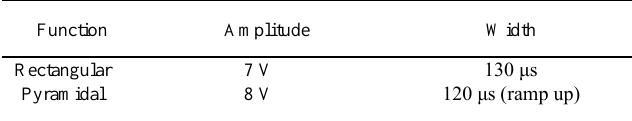
Table 1. Parameters for the definition of the